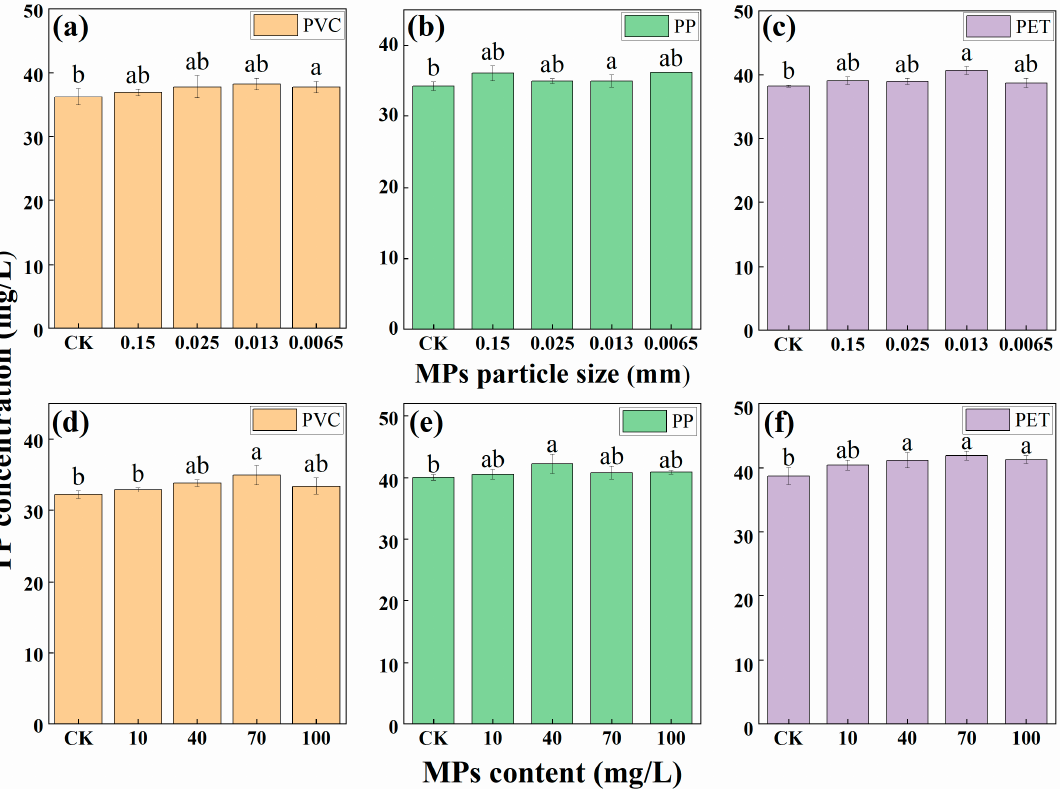
Figure 3. TP concentration in wastewater treated by MPs with different particle sizes ( a – c ) and contents ( d – f ). Different letters above the error bars indicate statistically significant differences ( p < 0.05).